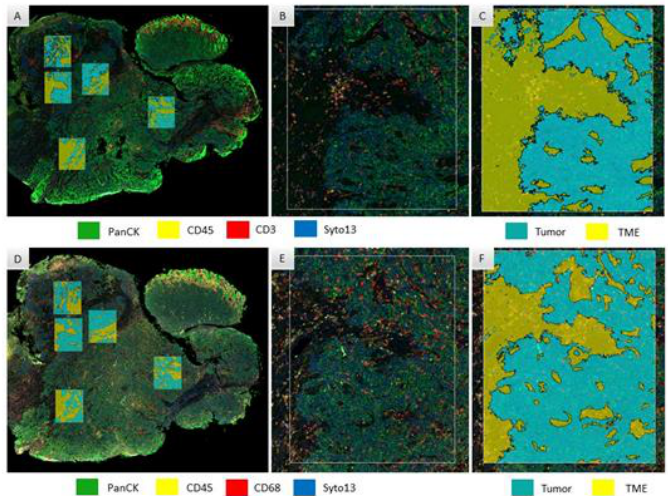
Figure 1. Region of interest selection and segmentation for protein ( A – C ) and RNA ( D – F ) digital spatial profiler assay in an anal carcinoma sample. All the areas selected for protein assay were matched for RNA assay, here seen with low magnification in ( A ) and ( D ), respectively; and at high magnification for one of the regions of interest in ( B ) and ( E ), respectively (colors for the immunofluorescence morphology staining are seen in rectangles on the bottom of these panels). ( C , F ) show tissue segmentation in the same high magnification area, for tumor and tumor microenvironment compartments (colors indicating mark-up areas for tumor and TME are seen on the bottom of these panels).